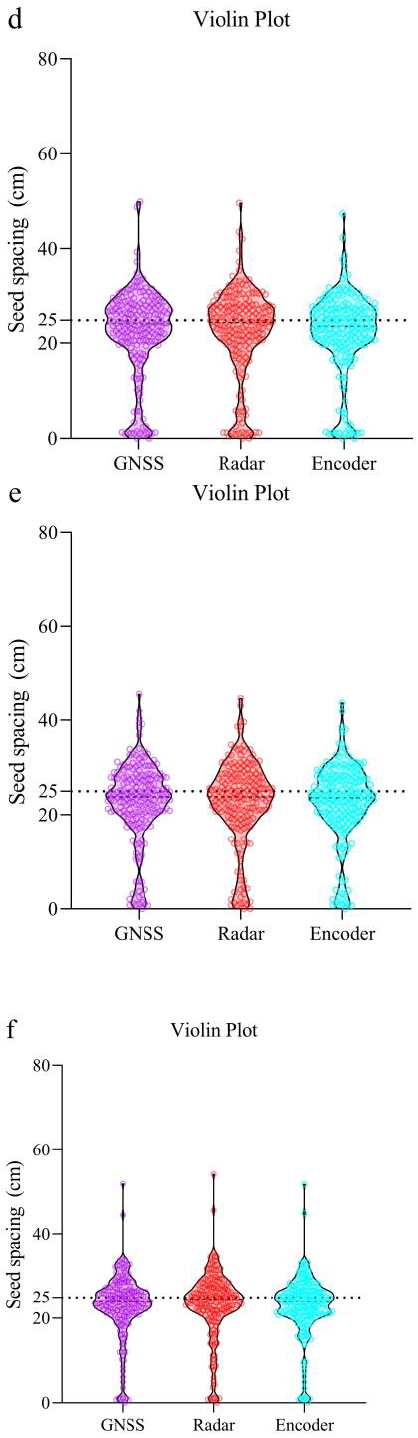
Figure 16. Violin plot of monitoring values of real-time seeding spacing (d, e, and f: three variable-speed seeding tests).